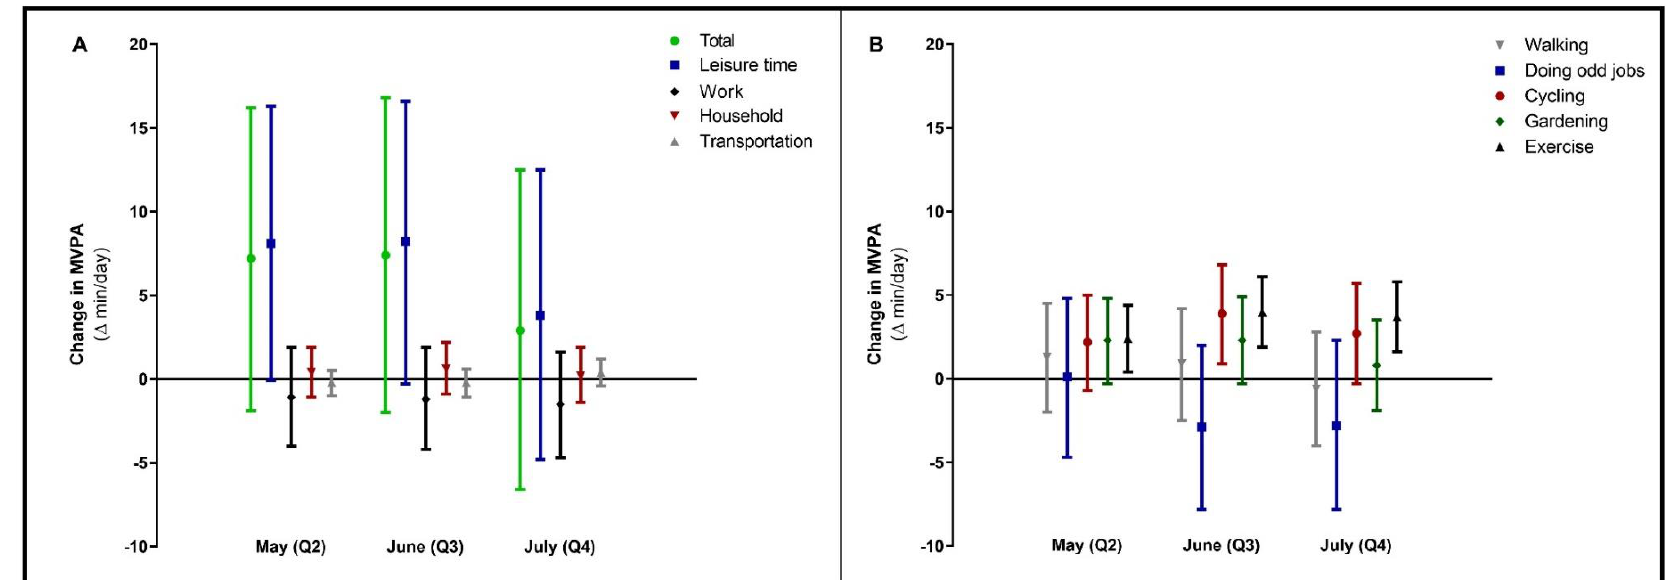
Figure 3. Changes in moderate-to-vigorous physical activity (MVPA, total and per different setting in panel ( A ) during the COVID-19 lockdown period. In panel ( B ), changes in the different sub settings of leisure time MVPA were specified. Data were reported as Δ (95% confidence interval) for follow-up measurements (Q2, Q3, Q4), with baseline (Q1) as reference category. Values were based on final multivariate mixed model analysis, adjusted for confounding factors.